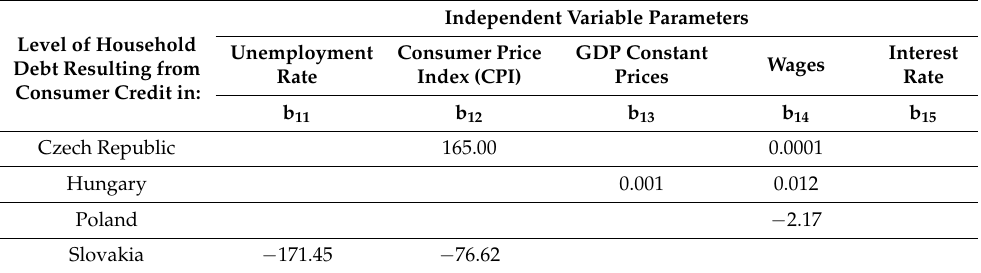
Table 3. Results of multiple linear regression analysis. Step